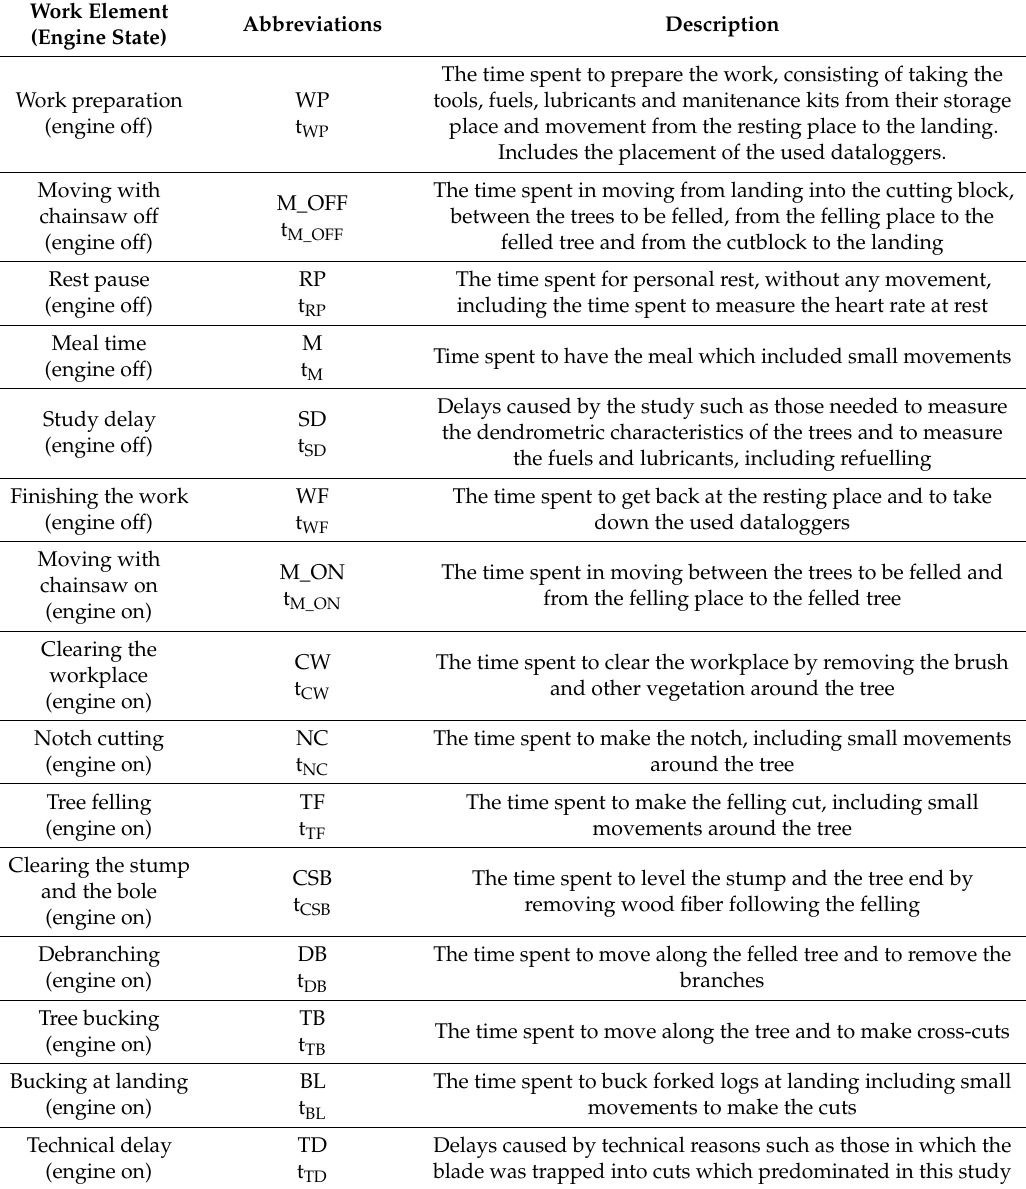
Table 2. Description of work and time elements that were specific to the